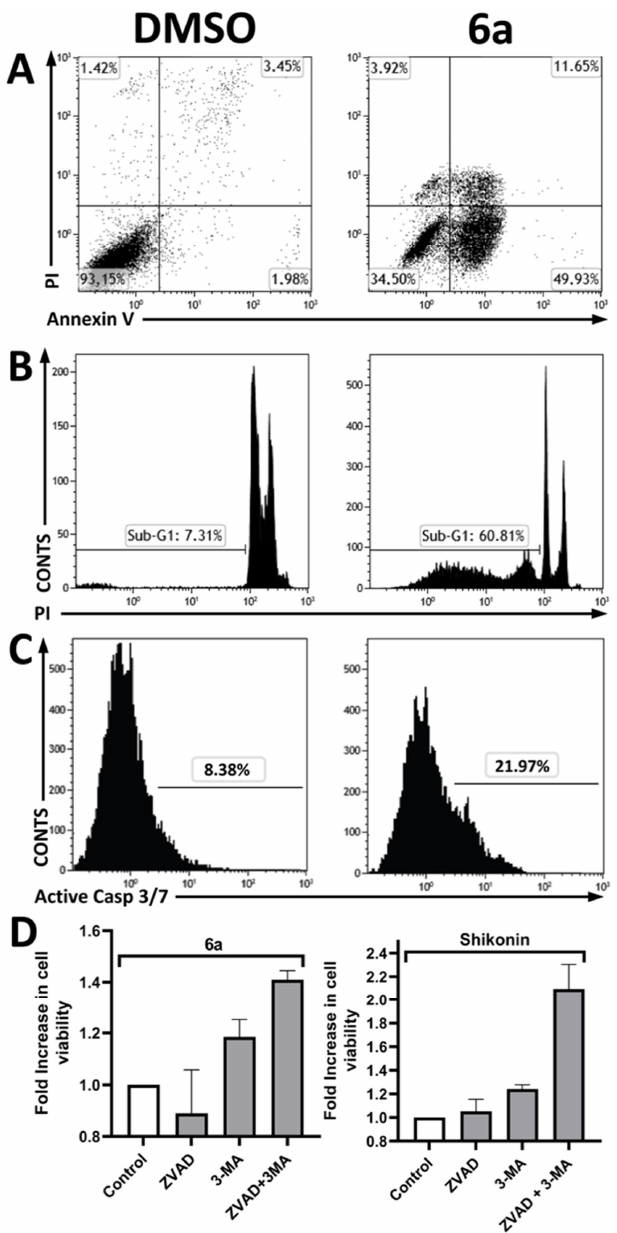
Figure 4. Compound 6a induces a late apoptotic phenotype possibly induced by autophagy. All experiments used SCC9 cells. ( A ) Analysis of phosphatidylserine exposure 48 h after plating. Cells were stained with annexin-V conjugated to FITC and P.I. and analyzed by flow cytometry. ( B )